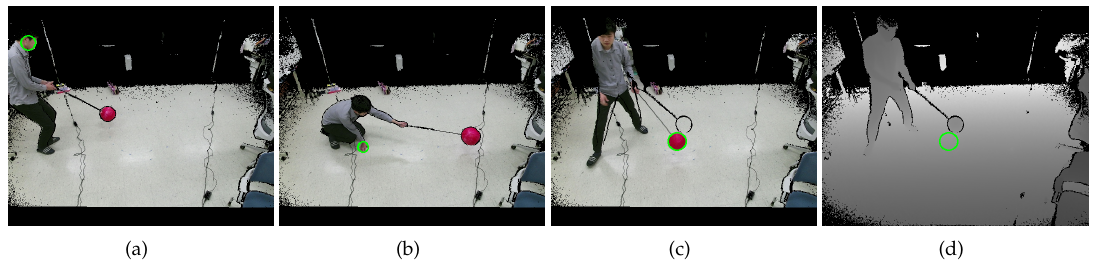
Figure 13. ( a , b ) show examples of misdetected circles. In ( c ), the circle has been accurately detected. However, in ( d ), the circular region does not match the sphere region in the corresponding depth image due to the asynchronous nature of the Kinect v2